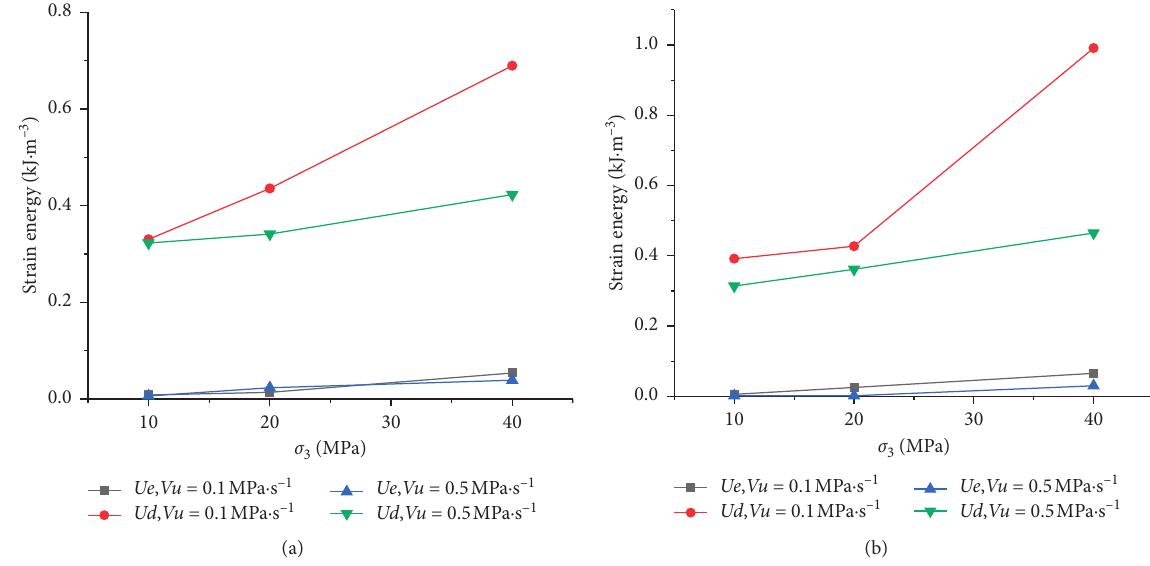
Figure 14: Strain energy eigenvalue curves of the unloading test at residual strength: (a) unloading triaxial test; (b) unloading confining- loading axial pressure